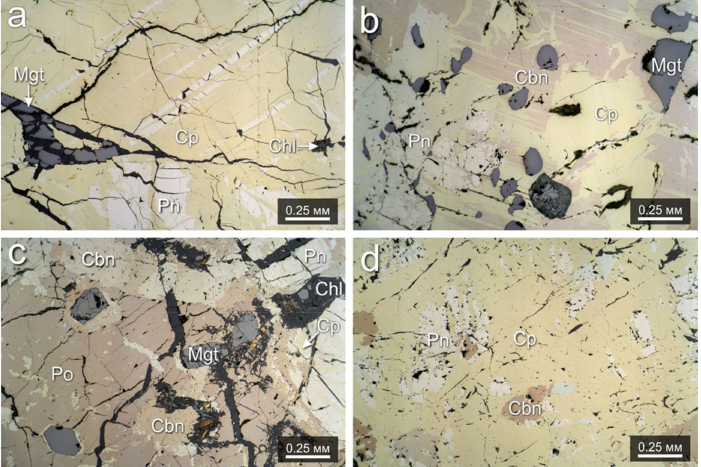
Figure 3. Main ore types in the cross-section of the Southearn-2 ore body along the EM-7 well. ( a ) Chalcopyrite-pentlandite ore from the upper chalcopyrite layer, depth 71.2 m; ( b ) Cubanite- pentlandite-chalcopyrite ore from the cubanite layer, depth 76.5 m; ( c ) Pyrrhotite-cubanite-pentlandite ore from the pyrrhotite layer, depth 78.6 m; ( d ) Chalcopyrite-cubanite-pentlandite ore from the lower chalcopyrite layer, depth 78.9 m. Reflected light, nicols are not completely crossed.